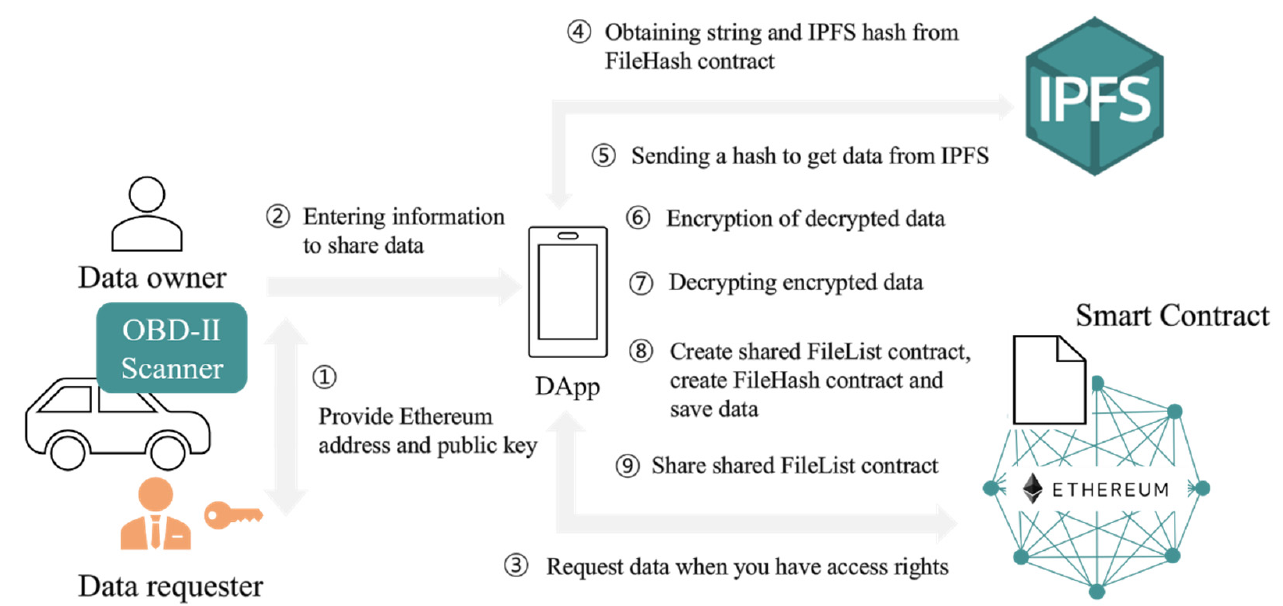
Figure 5. Process of sharing data.